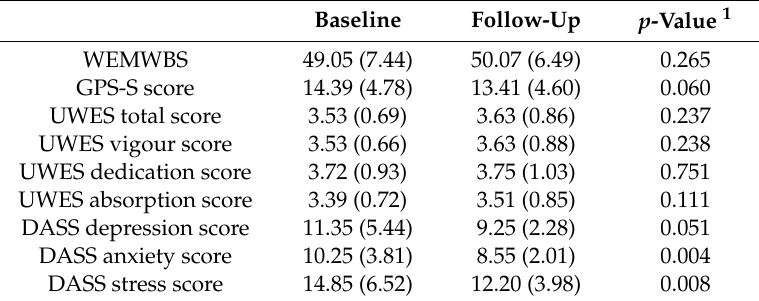
Table 5. Health and wellbeing questionnaire (mean ± SD; n = 41).